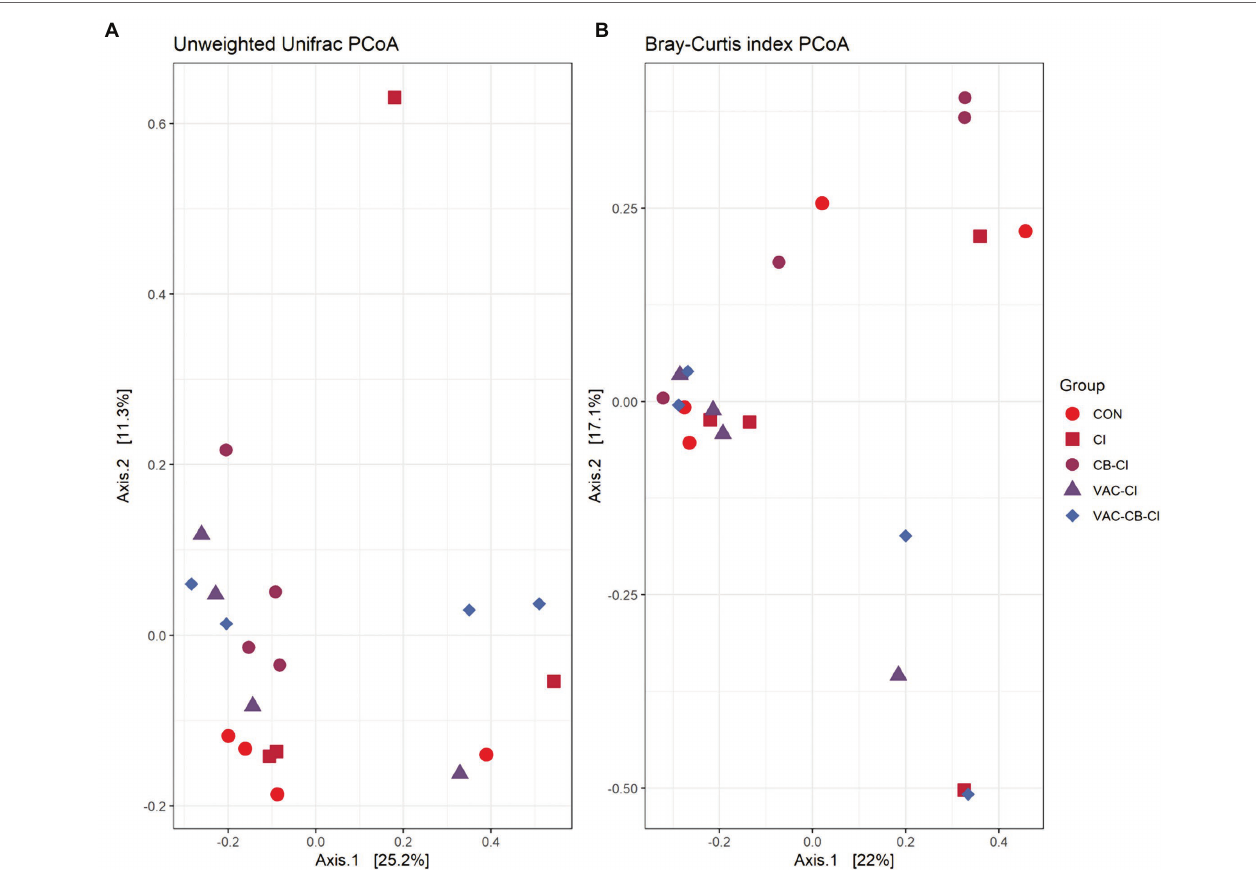
FIGURE 7 | Beta diversity assessment of the intestine microbiome from different samples pretreated with Clostridium butyricum and coccidiosis vaccine and then challenged with Eimeria sp. PCoA plots of unweighted UniFrac distances (A) and Bray–Curtis distances (B) between samples were drawn using phyloseq package. The bacterial microbiome of each sample is indicated with one dot. The color blocks of different color traits represent different experimental